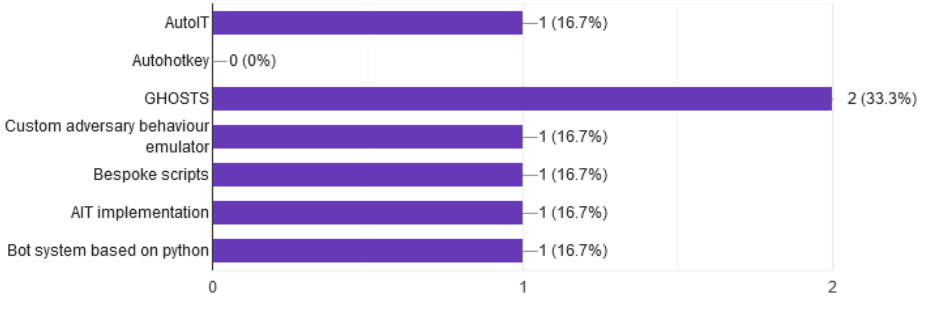
Figure 16. User behaviour.